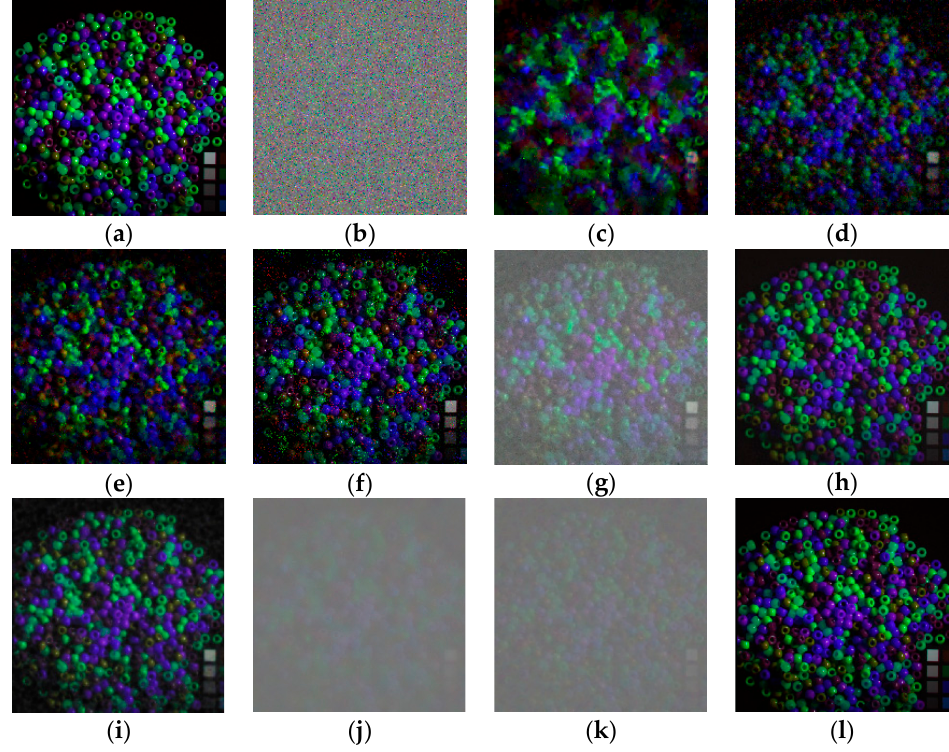
Figure 6. Restored images of Beads corrupted with Gaussian noise, sparse noise and missing pixels: ( a ) clean HSI; ( b ) noisy HSI; ( c ) BM3D; ( d ) ANLM3D; ( e ) BM4D; ( f ) LRMR; ( g ) GLF; ( h ) LRTDTV; ( i ) LTDL; ( j ) DnCNN; ( k ) HSID-CNN; ( l ) VLRM- Fmcl.